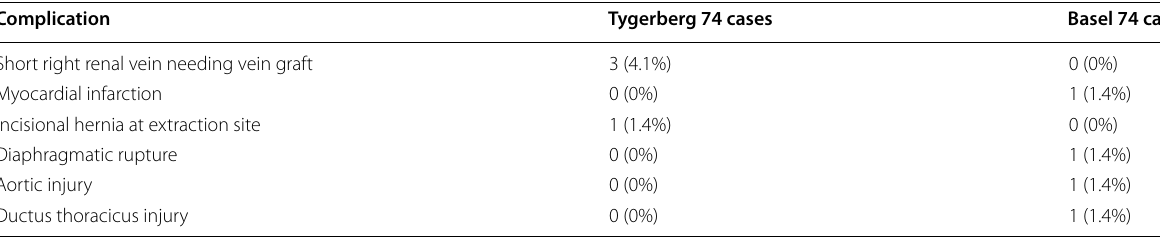
Table 2 Major complications needing intervention: number (%)